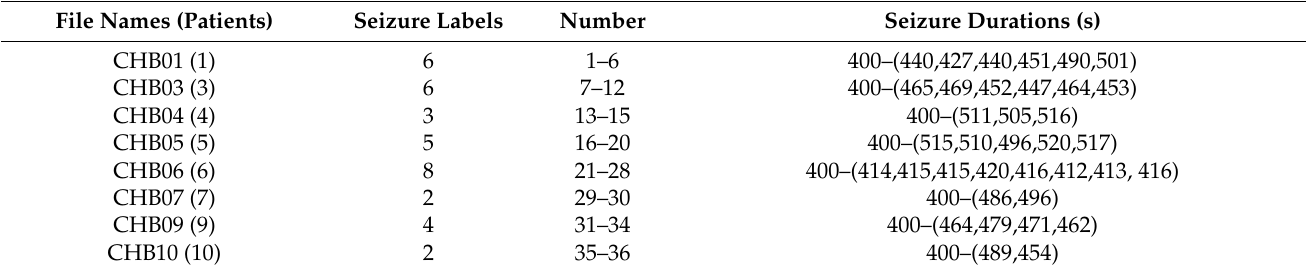
Table 1. EEG signals used in this study from CHB-MIT Scalp EEG